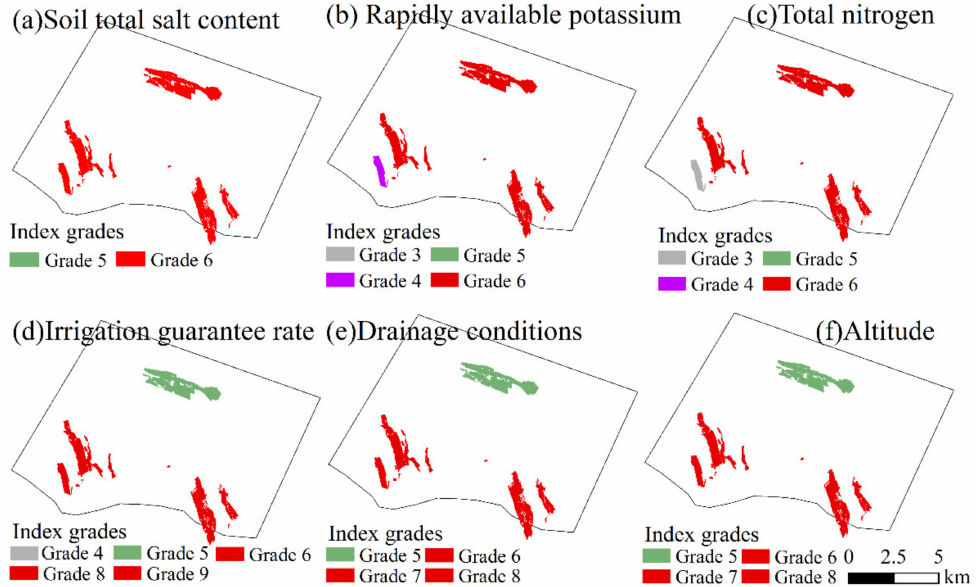
Figure 10. Spatial distribution of the influential factors at the edge of the diluvial fan. ( a ) Soil total salt content, ( b ) Rapidly available potassium, ( c ) Total nitrogen, ( d ) Irrigation guarantee rate, ( e ) Drainage conditions, and ( f )